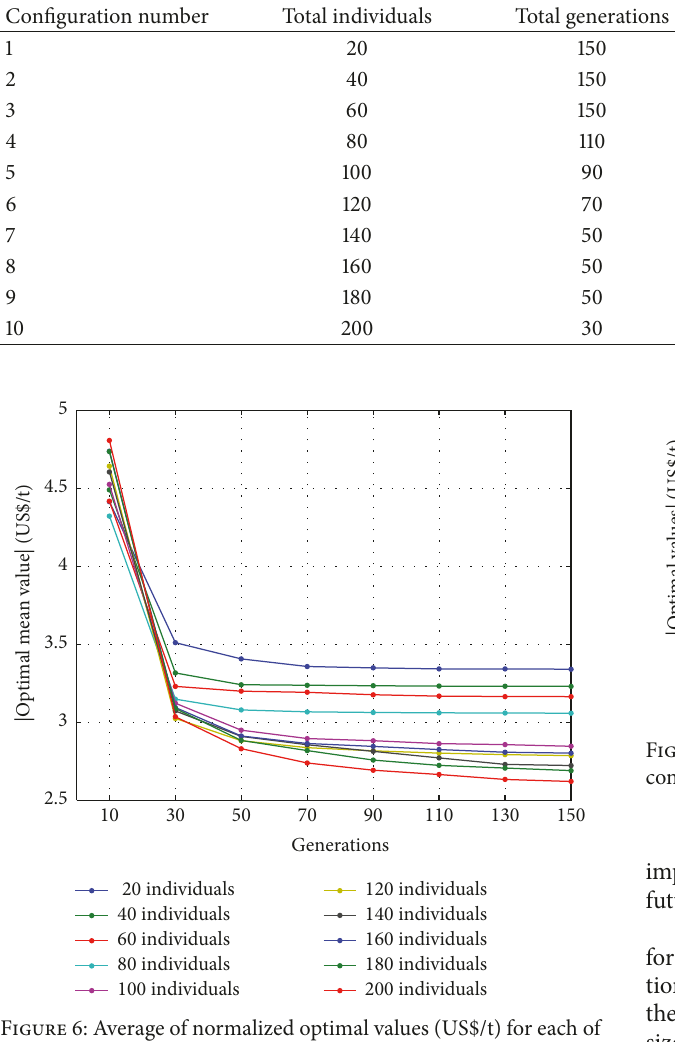
Figure 6: Average of normalized optimal values (US$/t) for each of the individuals and generations of AG-2.